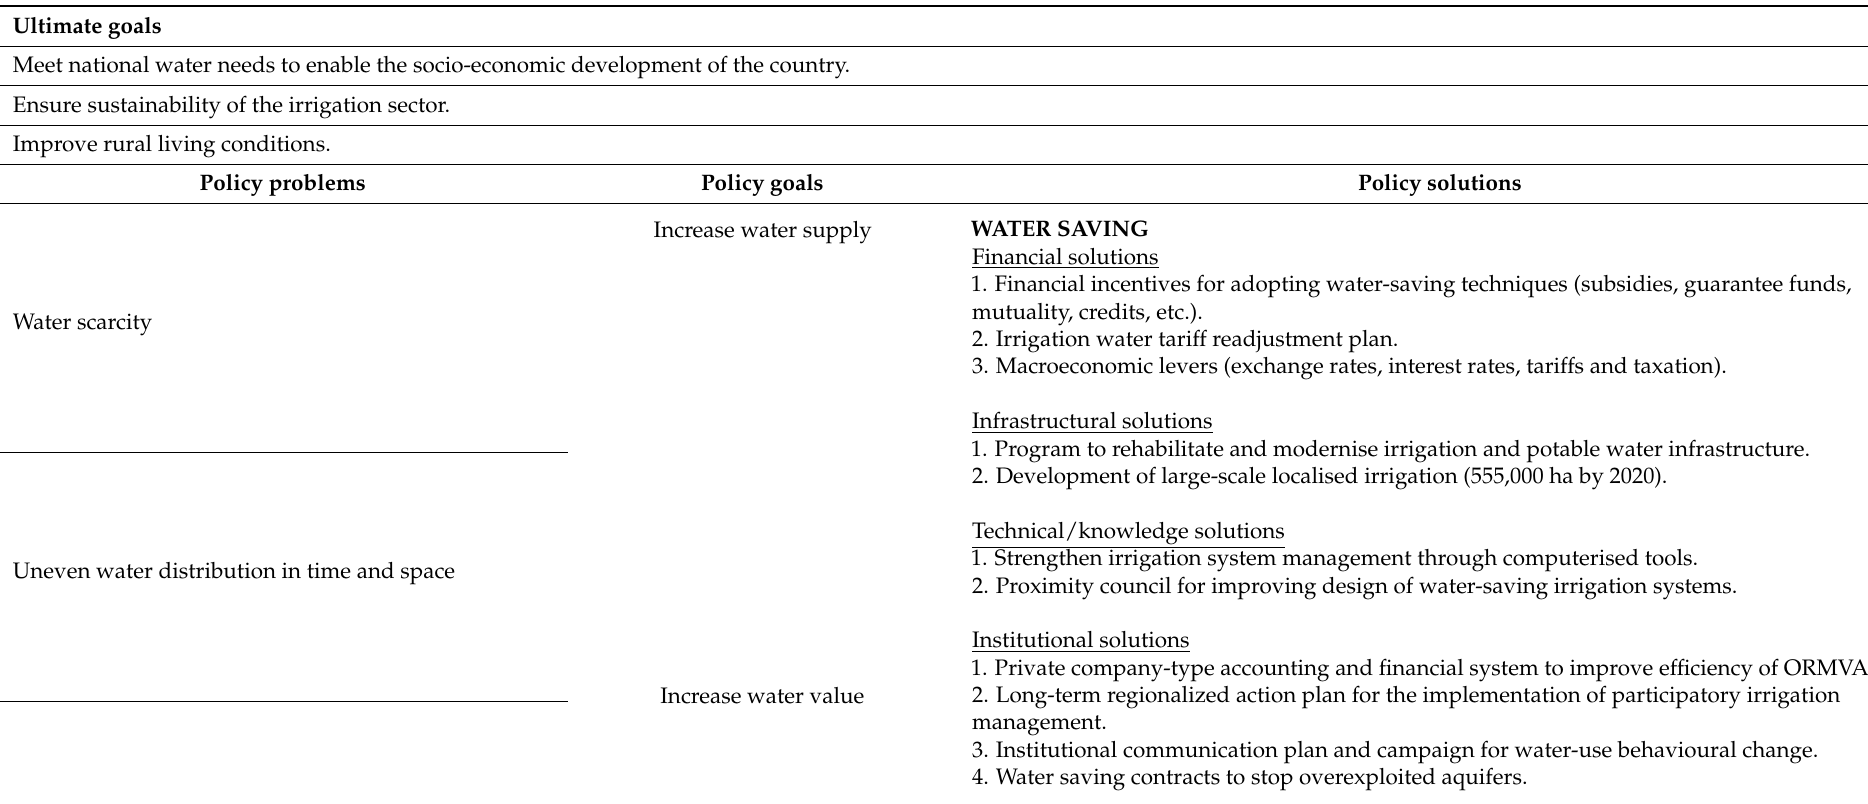
Table 2. Articulation of policy problems, policy goals, and policy